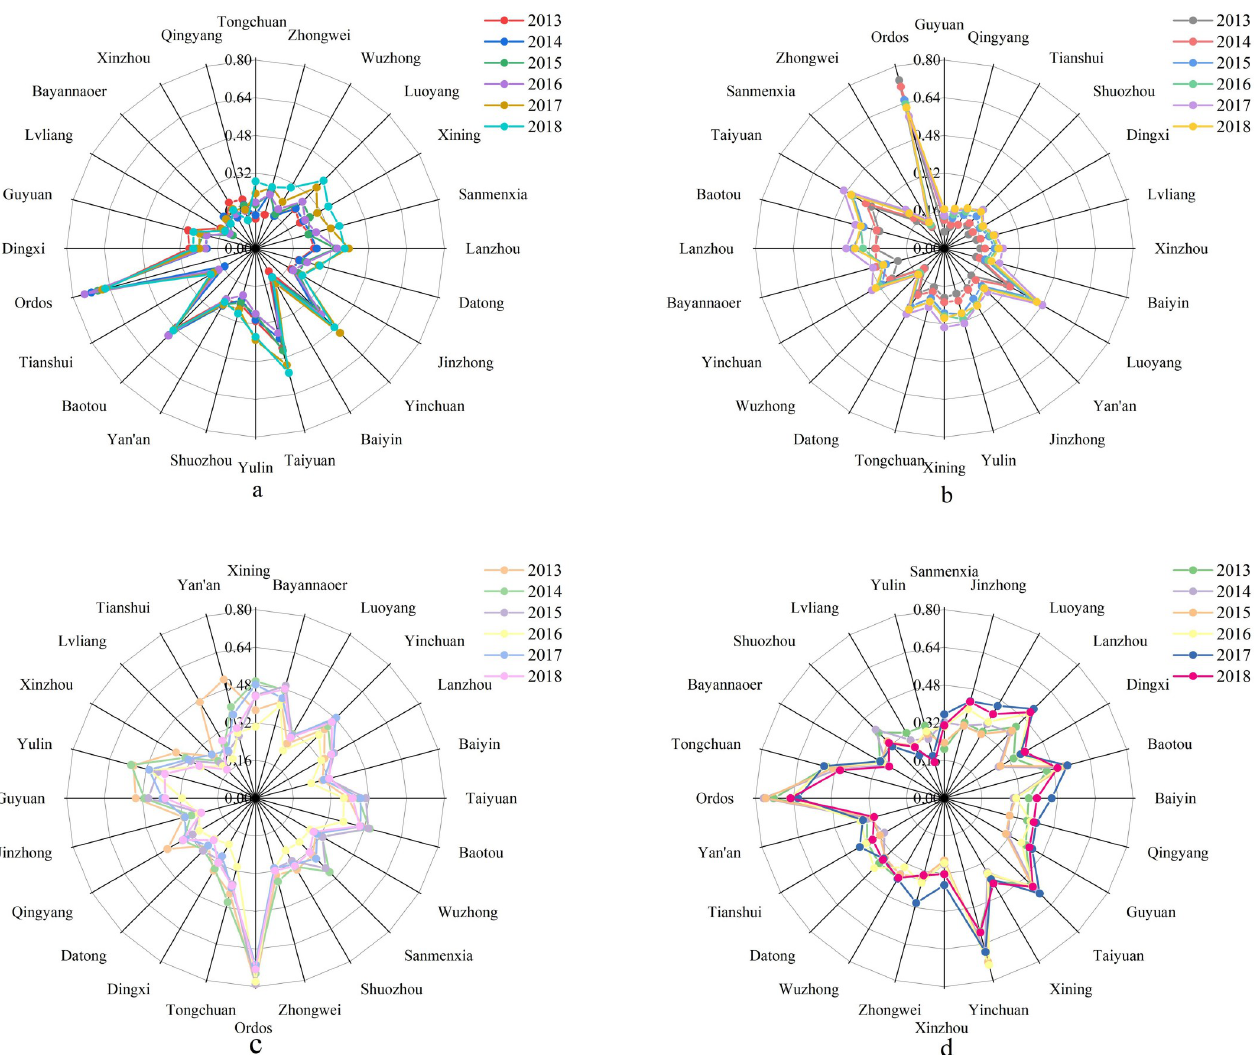
Fig 4. The calculation results of each subsystem carrying capacity in 24 cities from 2013 to 2018. (a) Economic carrying capacity; (b) Social carrying capacity; (c) Resource carrying capacity; (d) Environmental carrying